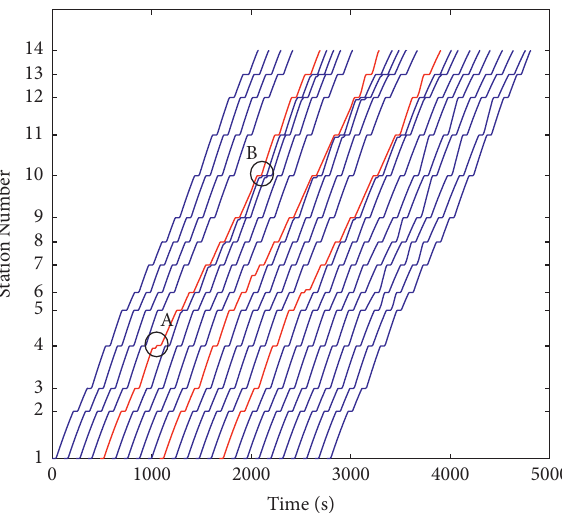
Figure 8: Practical timetable under Scenario 2.